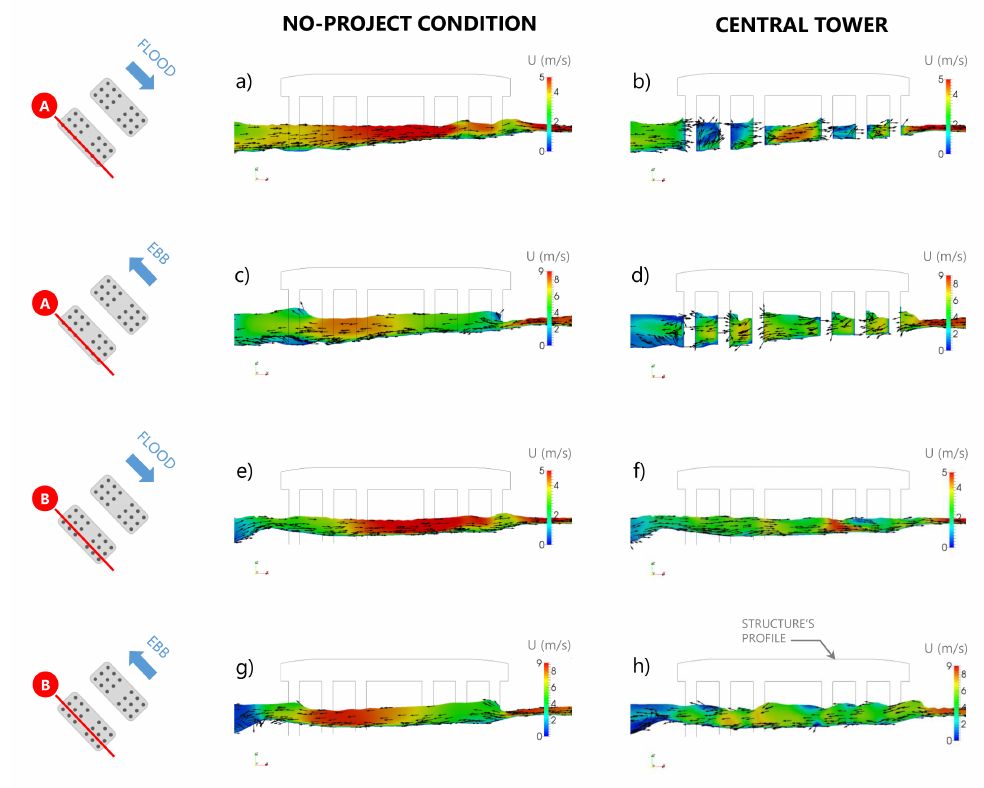
Figure 12. Side views of velocity fields at a vertical plane (A) coinciding with the southern-most line of piles in the CT site for the flood-tide ( a , b ) and ebb tide- scenarios ( c , d ) in the no-project condition and with the structure, respectively. Similar results at a vertical plane (B) between the southern-most and the immediate interior lines of piles for the flood-tide ( e , f ) and ebb tide- scenarios ( g , h ) in the no-project condition and with the structure, respectively. Arrows show the local flow direction and black lines delineate the structure’s profile. Figures adapted from